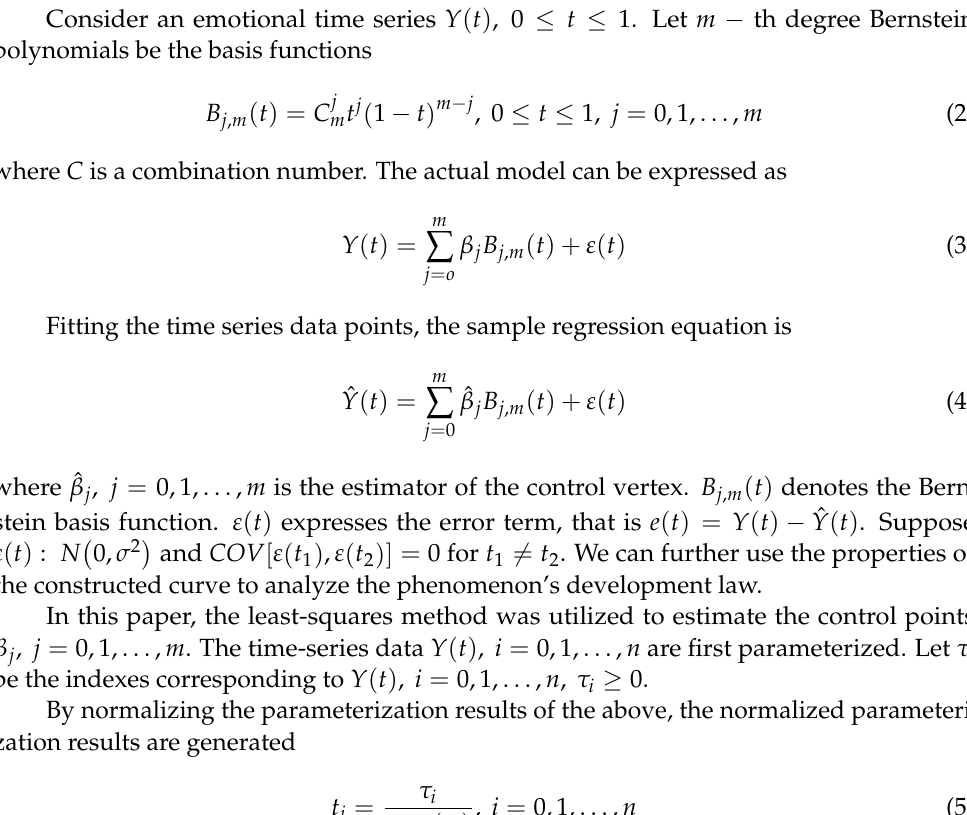
Figure 3. Convex hull diagram of Bernstein basis